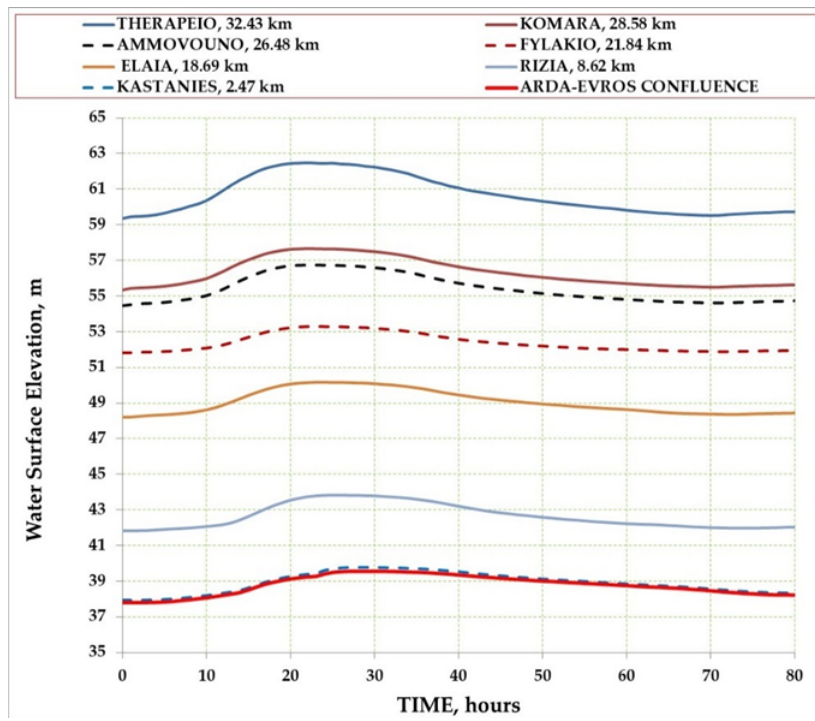
Figure 4. Free water surface elevation between levees as a function of time at various characteristic cross-sections along the river.